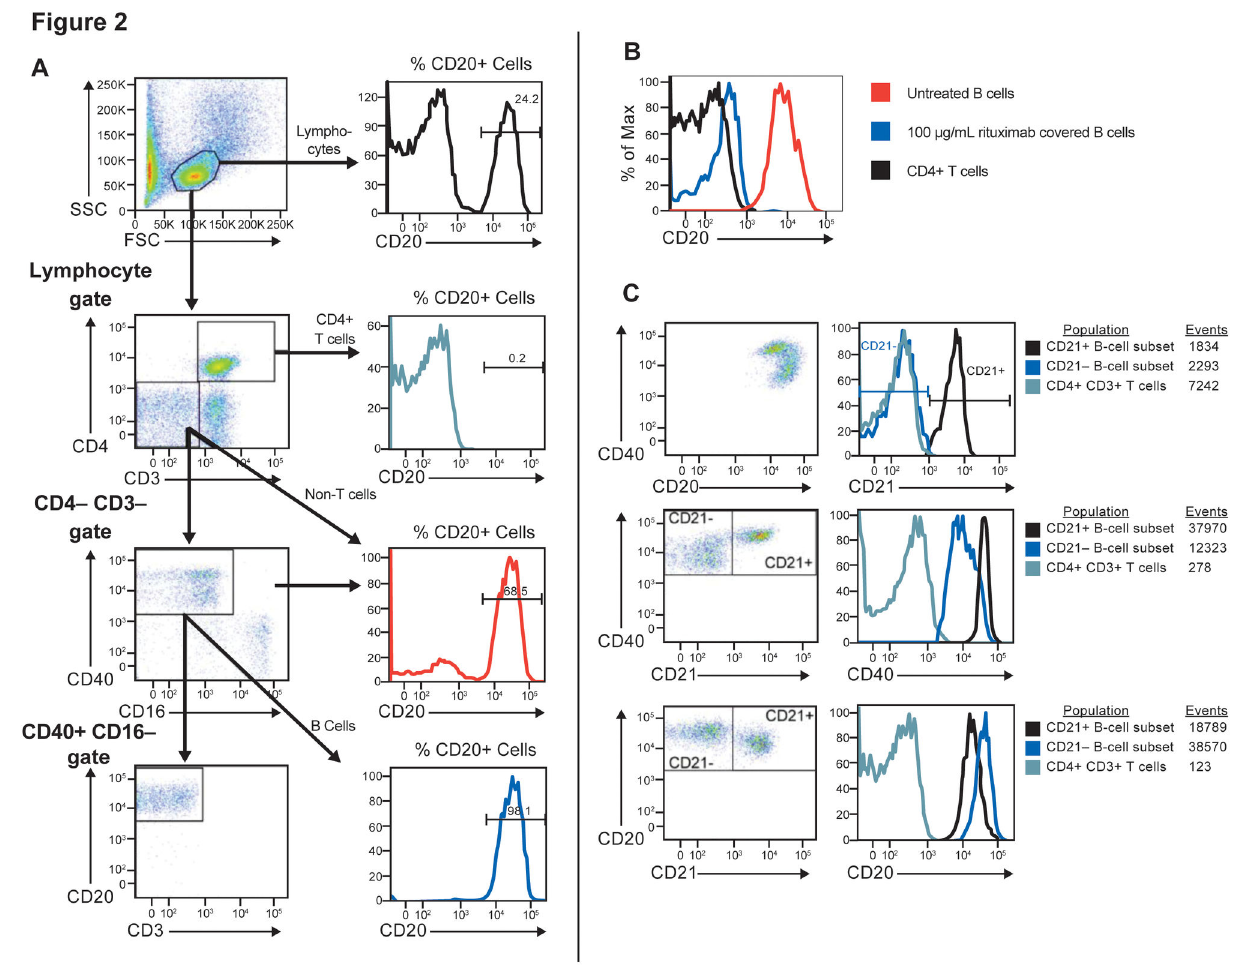
Figure 2. CD20 target coverage in B-cells and according to CD21+ status. Paradigms for flow cytometry staining: ( A ) CD20- independent identification of B cells using fsc/scc lymphocyte gating followed by CD4/CD3 negative gating and CD40 positive CD16 negative gating shows a progressively increasing specific B cell population; ( B ) Free surface CD20 levels on B cells (as identified in A) with and without rituximab treatment to show target coverage of CD20 compared to CD4+/CD3+ T cells; ( C ) Identification of CD21+ and CD21- peripheral blood B-cell subsets (within the CD4-/CD3-/CD16-/CD40+ gated B cells as identified in A) showing CD21, CD40 and CD20 levels of the subsets. doi: